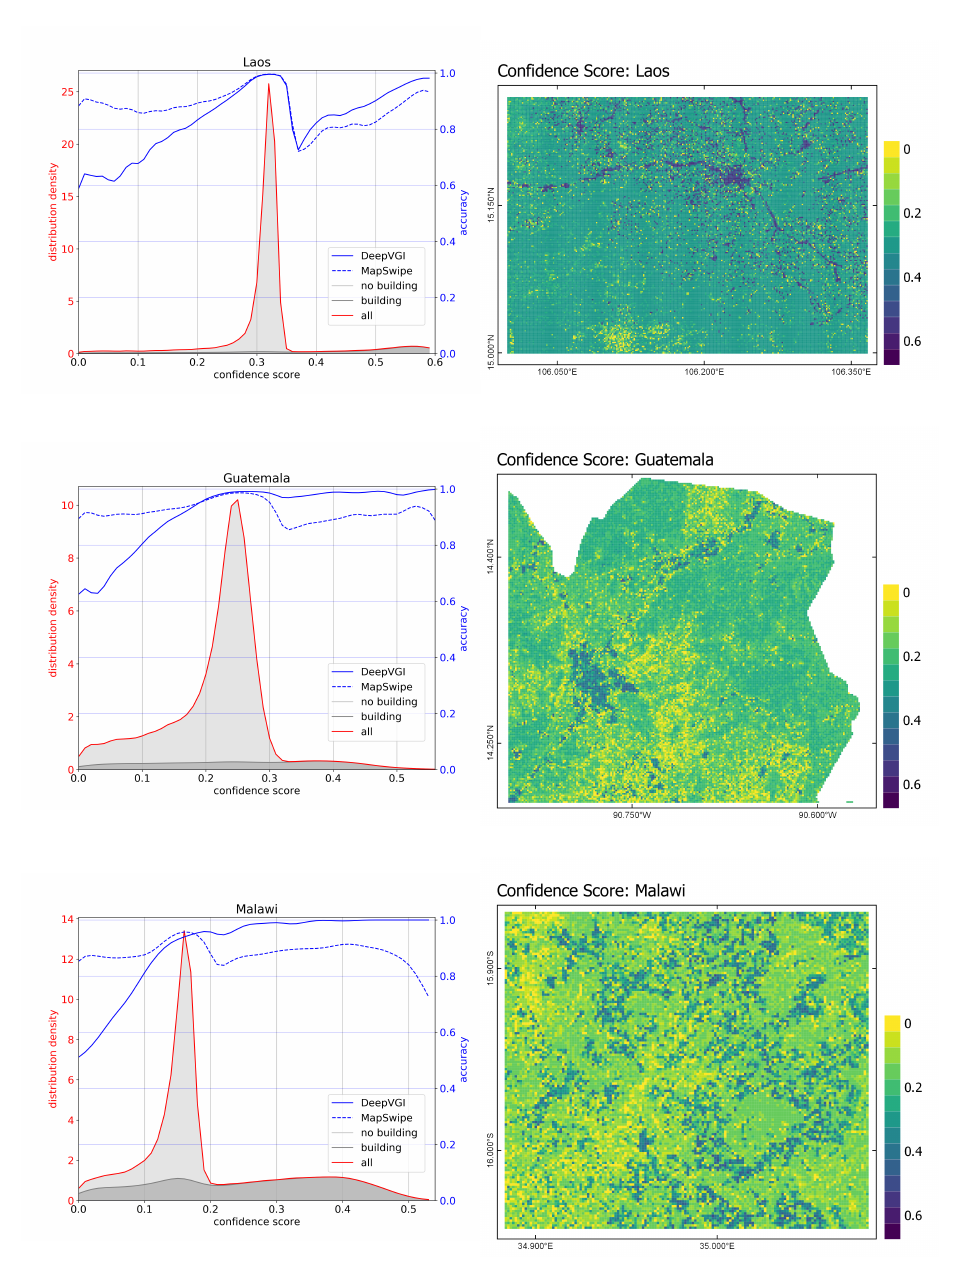
Figure 6. Spatial and Non-Spatial Distribution of the Confidence Score and Conditional Density of Accuracy for Laos, Guatemala and Malawi. The figure provides insights on the kernel density distributions of the confidence scores of “all” (red line), “no building” (light gray) and “building” (dark gray) tiles for the different study regions (red axis). The same plot shows the conditional distribution of accuracy (blue axis) for DeepVGI (solid blue line) and MapSwipe (dashed blue line). The map depicts the spatial distribution of the confidence